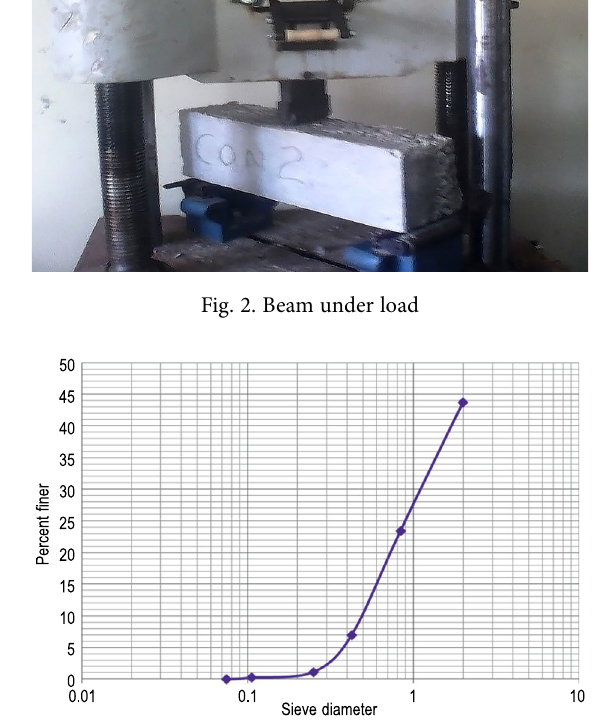
Fig. 3. Grain size distribution for polypropylene grains